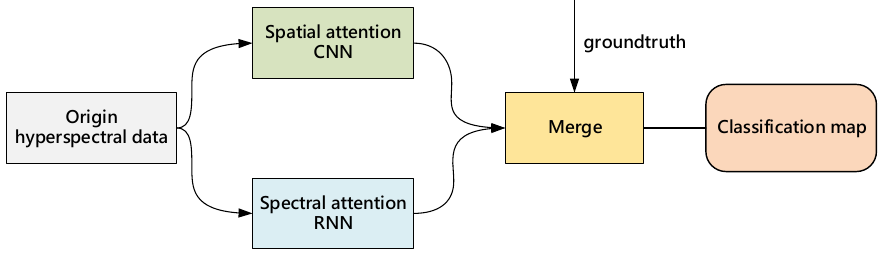
Figure 1. Our framework for hyperspectral images (HSI) classification. It consists of a spatial attention convolutional neural network (CNN) branch and a spectral attention recurrent neural network (RNN) branch, followed by a merge block which learns spectral-spatial features